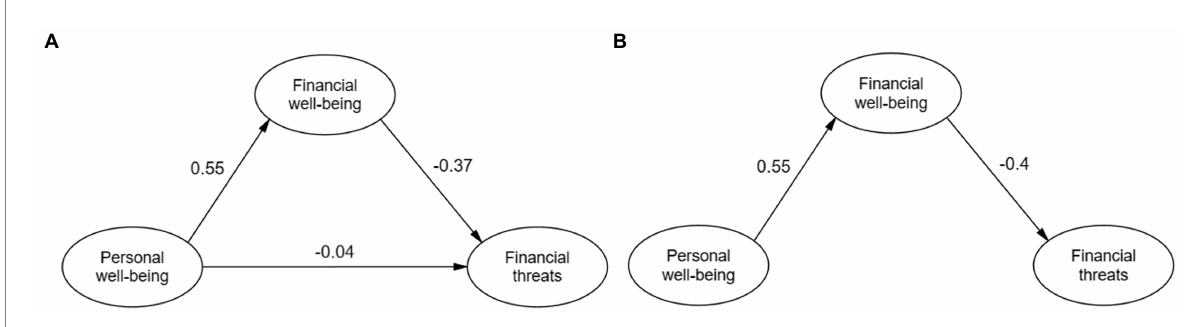
FIGURE 2 Results of the structural model: (A) Including direct effect and (B) excluding direct